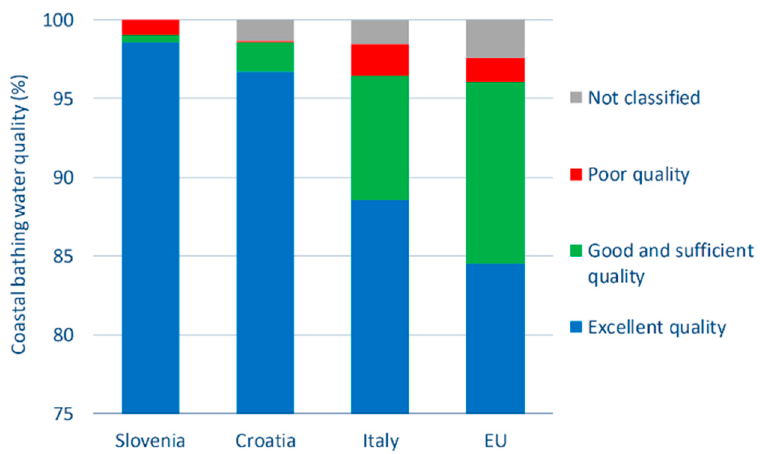
Figure 12. Ten-year average of coastal bathing water quality in Croatia and neighboring EU Member